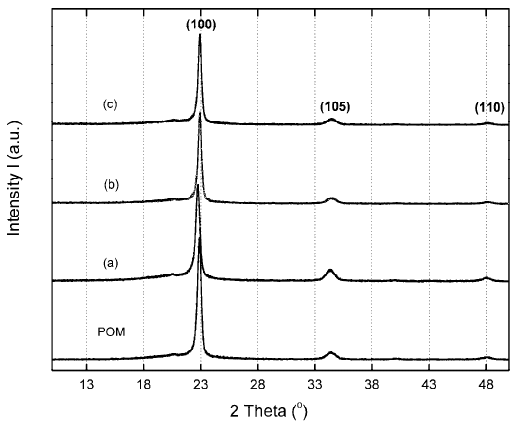
Figure 6. WAXD curves of pure POM and its composites with different GPOSS concentrations at room temperature: ( a ) 0.05 wt. %; ( b ) 0.1 wt. %; ( c ) 0.25 wt. %.